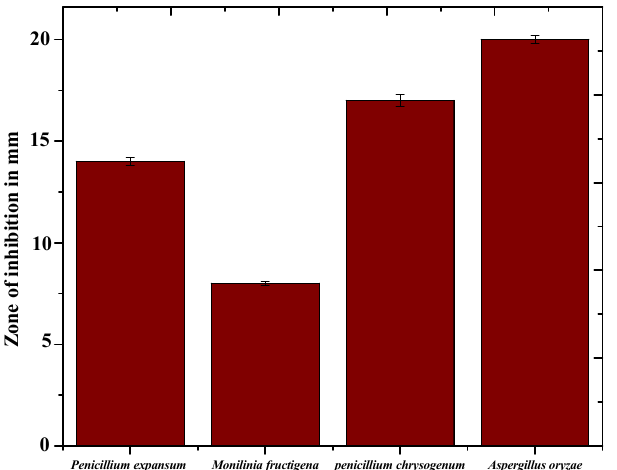
Figure 7. Shows the zone of inhibitions of NPs against ( A ) Penicillium expansum, ( B ) Monilinia fructigena, ( C ) Penicillium chrysogenum, and ( D ) Aspergillus oryzae.